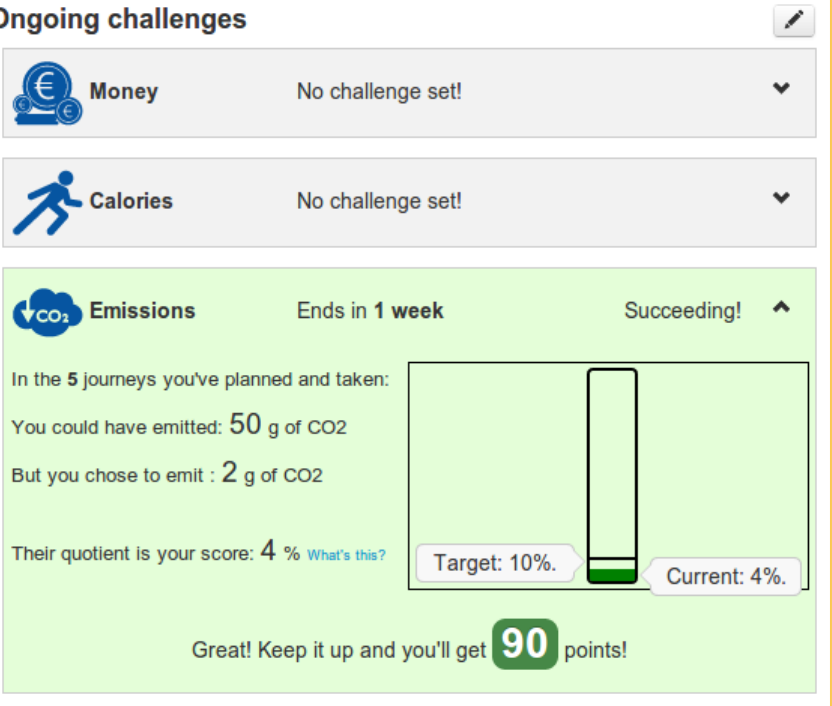
Figure 5. This figure illustrates the challenge screen that is displayed to the user when they are succeeding in a